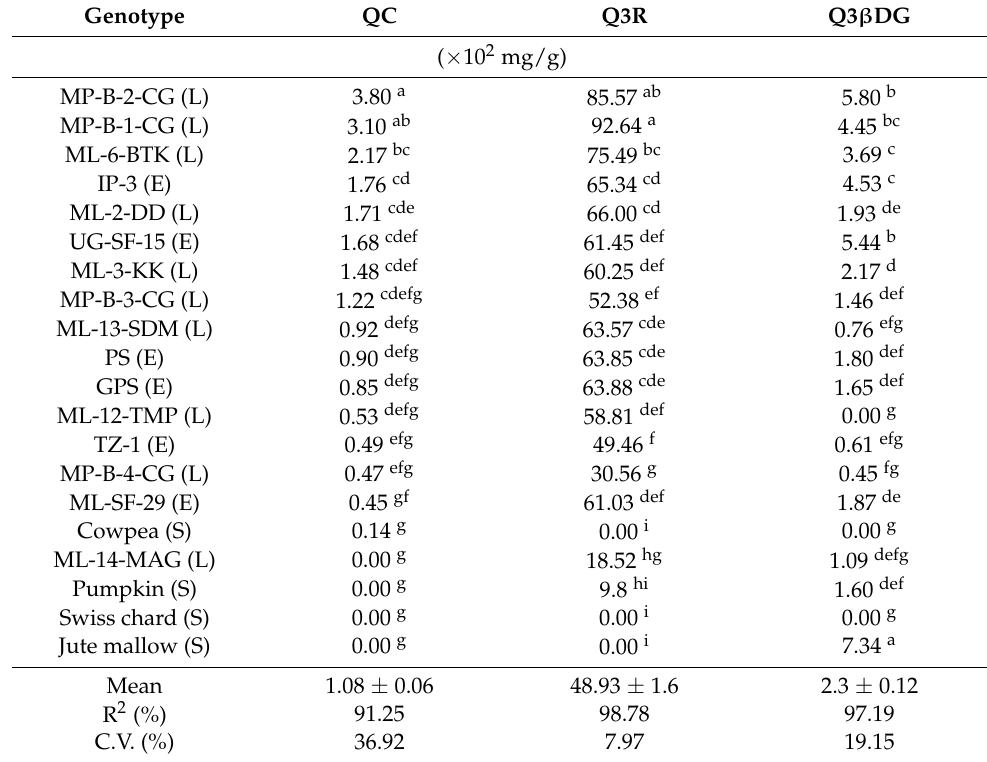
Table 4. Phenolic compounds in spider plant genotypes, swiss chard, pumpkin, cowpea, and jute